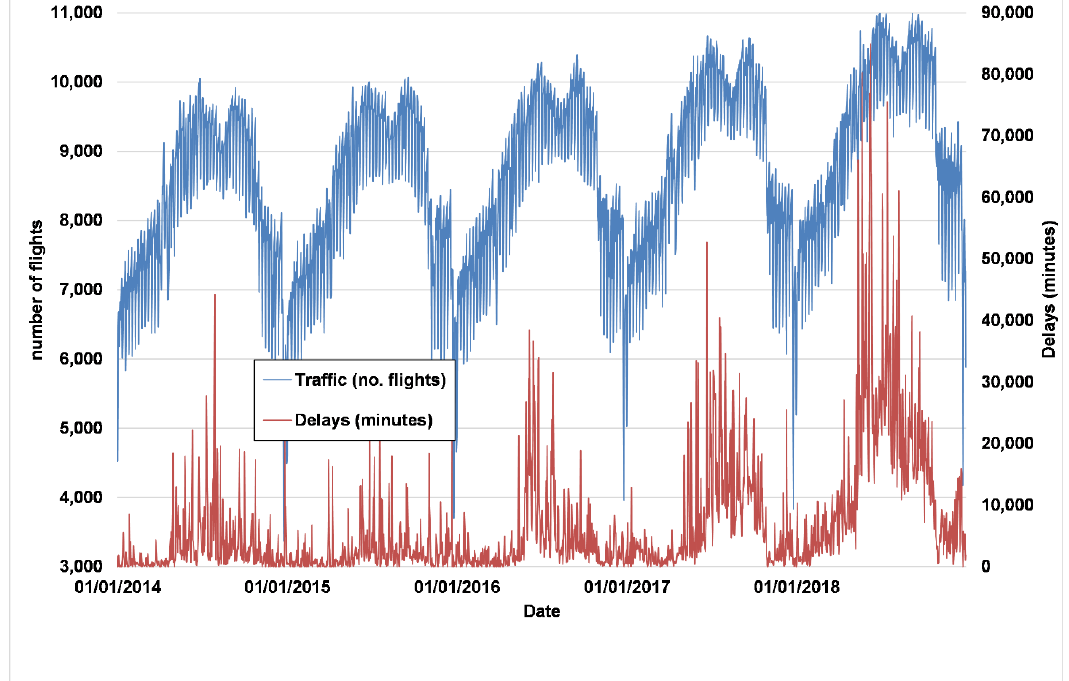
Figure 1. Number of daily flights and delays Germany (from 1/1/2014 to